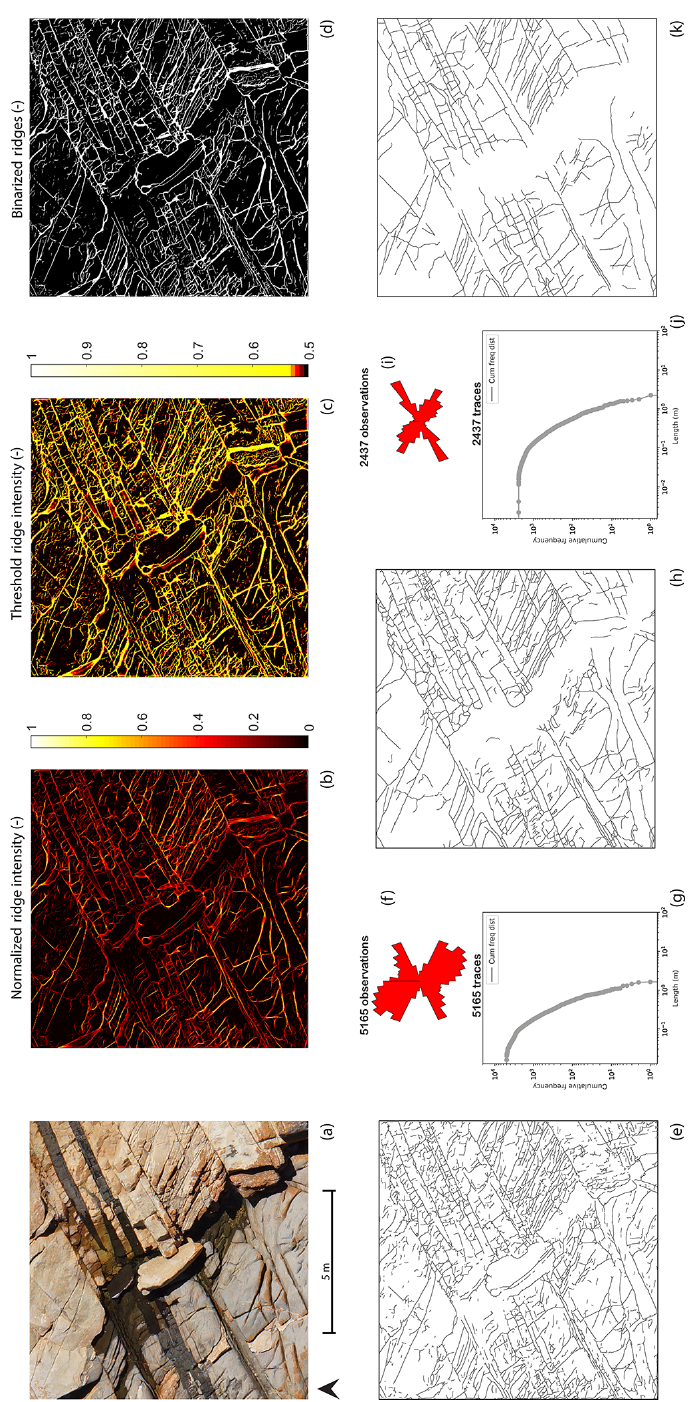
Figure 14. Comparison of benchmark image 1. (a) Bingie Bingie area 1 from Thiele et al. (2017a). This image is available for download at https://doi.org/10.4225/03/5981b31091af9 (Thiele et al., 2017b) under a CC-BY-4.0 license. (b) Normalized ridge map using complex shearlet automatic extraction. (c) Threshold applied to the normalized ridges. (d) Binarized ridges map. (e) Vectorized automatic traces. (f) Length-weighted rose plot of the automatic interpreted traces. (g) Cumulative frequency plot of the automatic interpreted traces. (h) As- sisted cleaned-up trace map for area 1. (i) Length-weighted rose plot of the assisted traces. (j) Cumulative frequency plot of the assisted traces. (k) Assisted trace interpretation modified from Thiele et al. (2017a) for comparison.